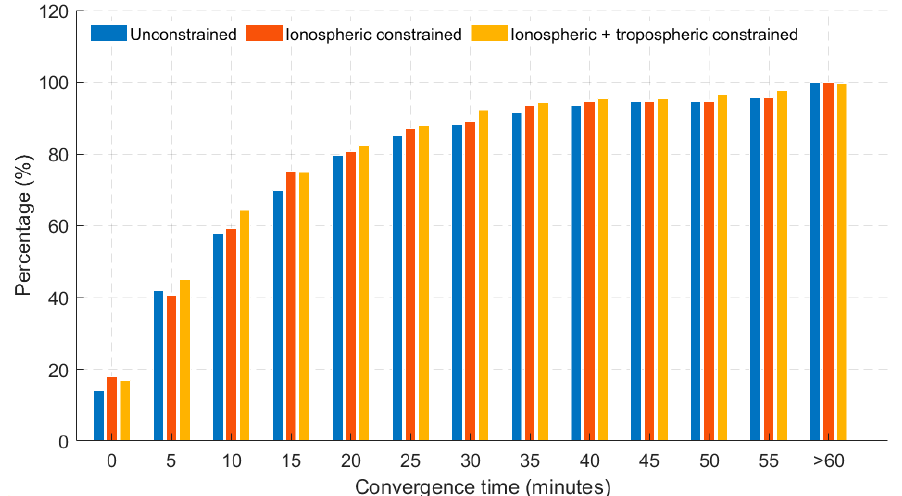
Figure 10. Histogram showing percentage of 40 stations converging based on 24 hourly solutions in dual-frequency GREC with GPS-AR processing mode. Results shown have a 20 cm horizontal error threshold.